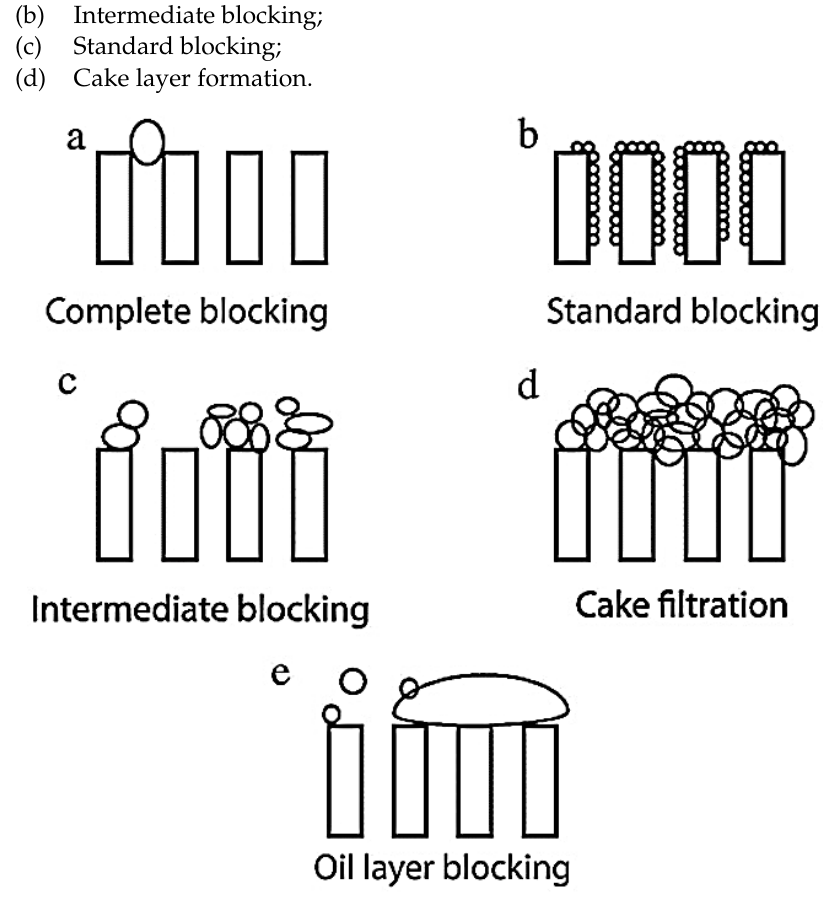
Figure 1. Schematic representation of the different fouling mechanisms taking place on the membrane surface [53]. Reprinted with permission from Ref. [53]. Copyright 2016 Elsevier Inc. (Amsterdam, The Netherlands). All rights reserved.